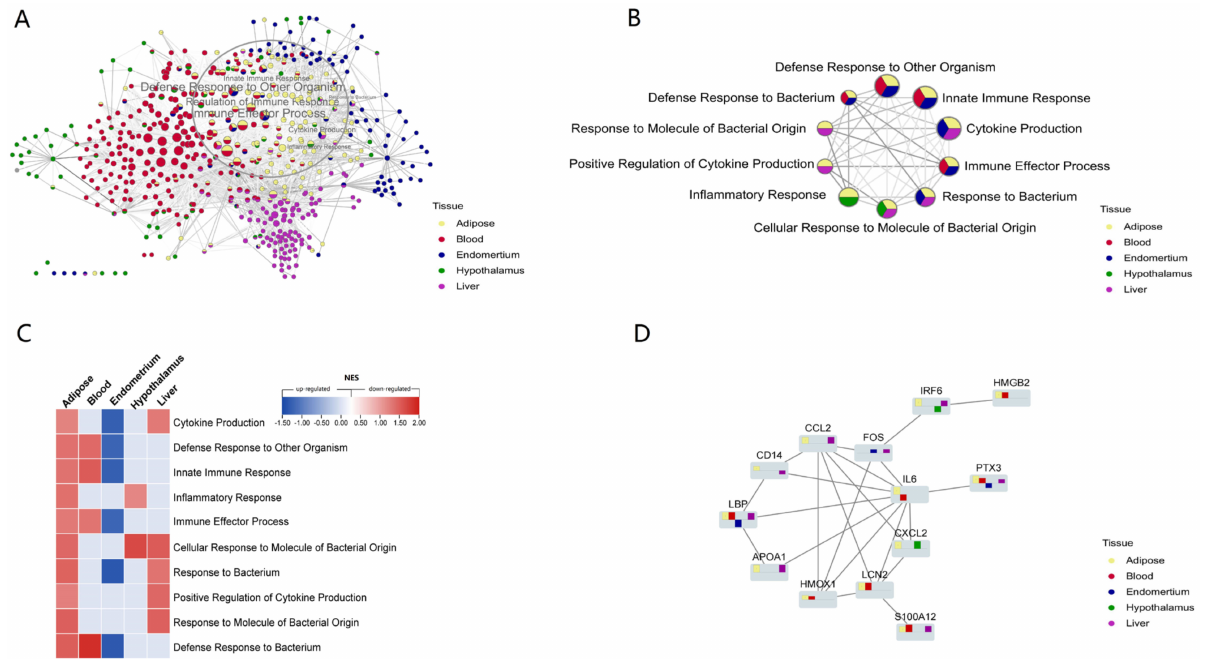
Figure 4. NEB altered the defense and inflammation-related processes and innate immune genes. ( A ) The cluster of the biological processes enriched from different tissues by GSEA as similarity, and different colors of pie plots means shared processes of multi-tissue. The processes in the circle are mainly related to defense and inflammation. ( B ) The network of shared hub processes related to defense and inflammation from multi-tissue. ( C ) The heatmap of NES value of the processes enriched from the five tissues. ( D ) The PPI network of the shared DEGs with great differences. The bar graph shows upregulation above the baseline and downregulation below. The y-axis shows